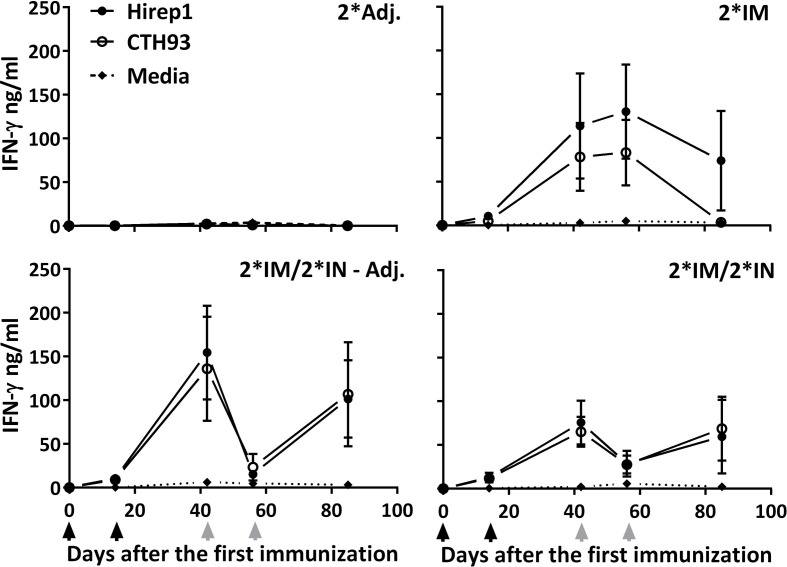
Cell-mediated IFN-γ response during the immunization period. The groups of minipigs were immunized according to Figure 1 with Hirep1 and CTH93, and the cell-mediated immune response was evaluated during the immunization period by isolating PBMCs, re-stimulating them with Hirep1, CTH93, and media whereafter the IFN-γ levels were determined in the supernatant. Graphs show mean ± SEM. The black arrows indicate the two IM immunizations and the two gray arrows indicate the two IN immunizations.